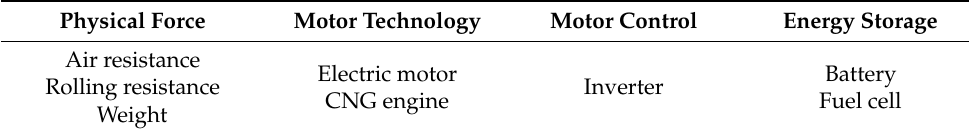
Table 5. Technology areas to be